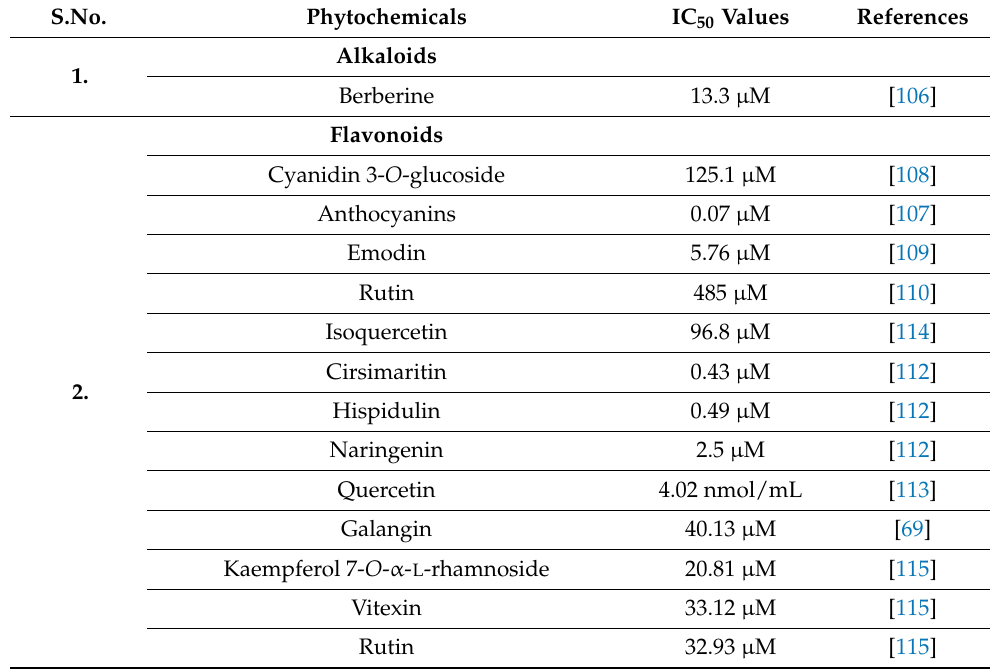
Table 3. Natural compounds with DPP-4 inhibition and their corresponding IC 50